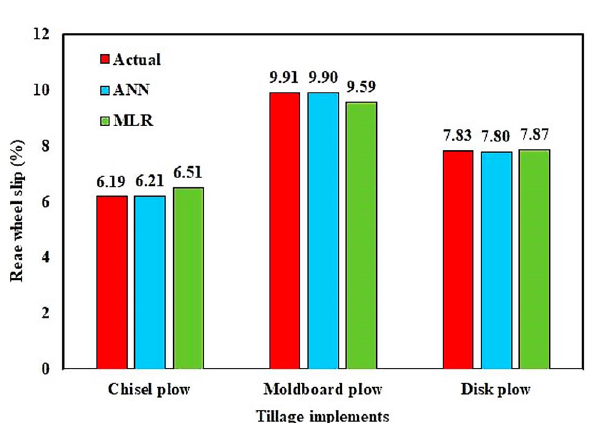
Figure 13. The average rear wheel slip from the ANN and MLR models compared to actual values of the three tillage implements using testing dataset.